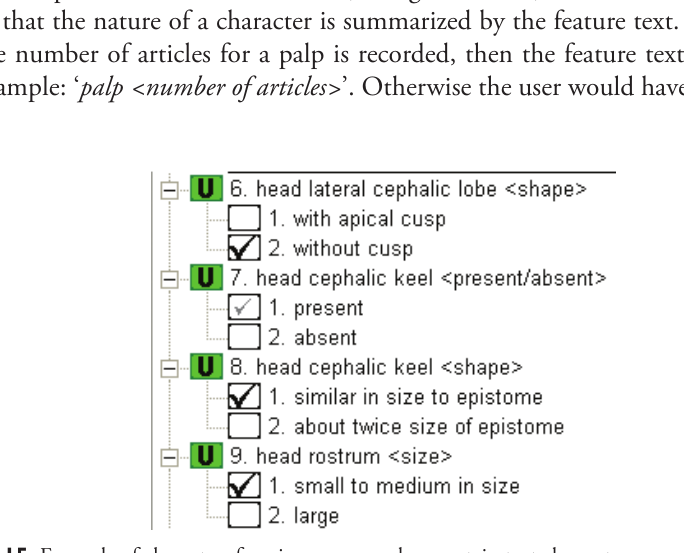
Figure 15. Example of characters forming a group where certain text elements are